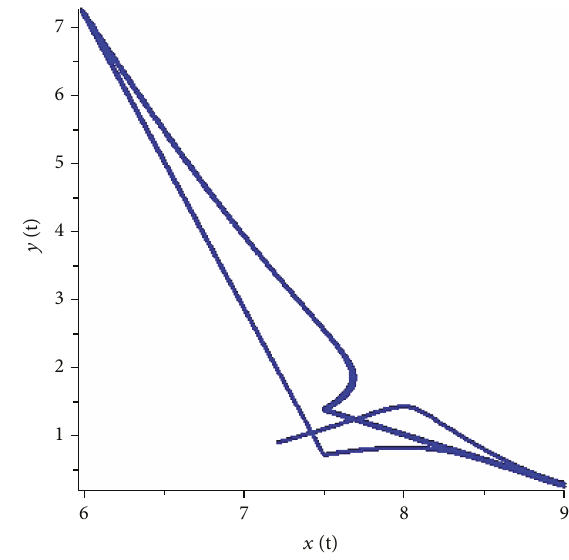
Figure 21: There exists an order-2 periodic solution in system (16) with q 1 = 1/6 , p = 0 9 , and τ = 1 1